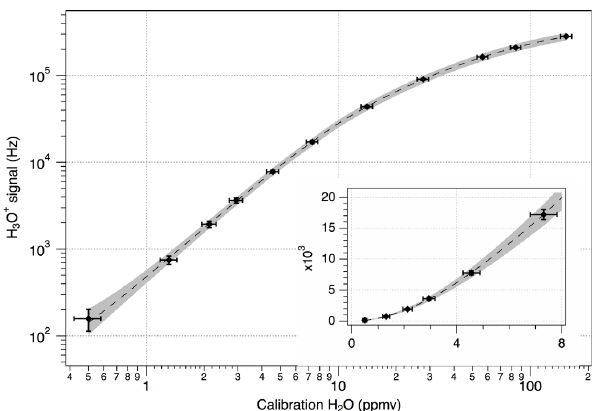
Fig. 6. CIMS calibration curve showing the non-linearity of the re- sponse to H 2 O. The data are fit piecewise using two overlapping Hill equation (sigmoidal) curves, one for the lower 7 data points and one for the upper 7 data points. The grey shaded region repre- sents the experimental uncertainty in the fit.